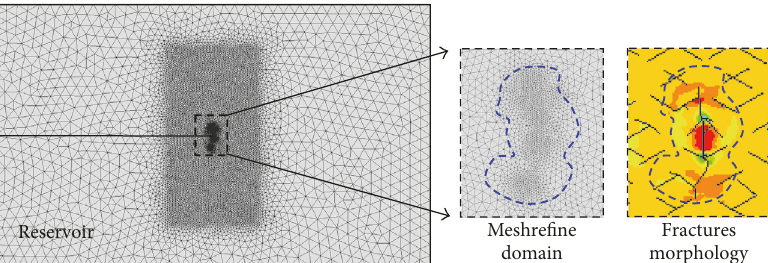
Figure 7: Final mesh around the domain of hydraulic and pre-existing fractures in gas production stage in naturally fractured reservoir.